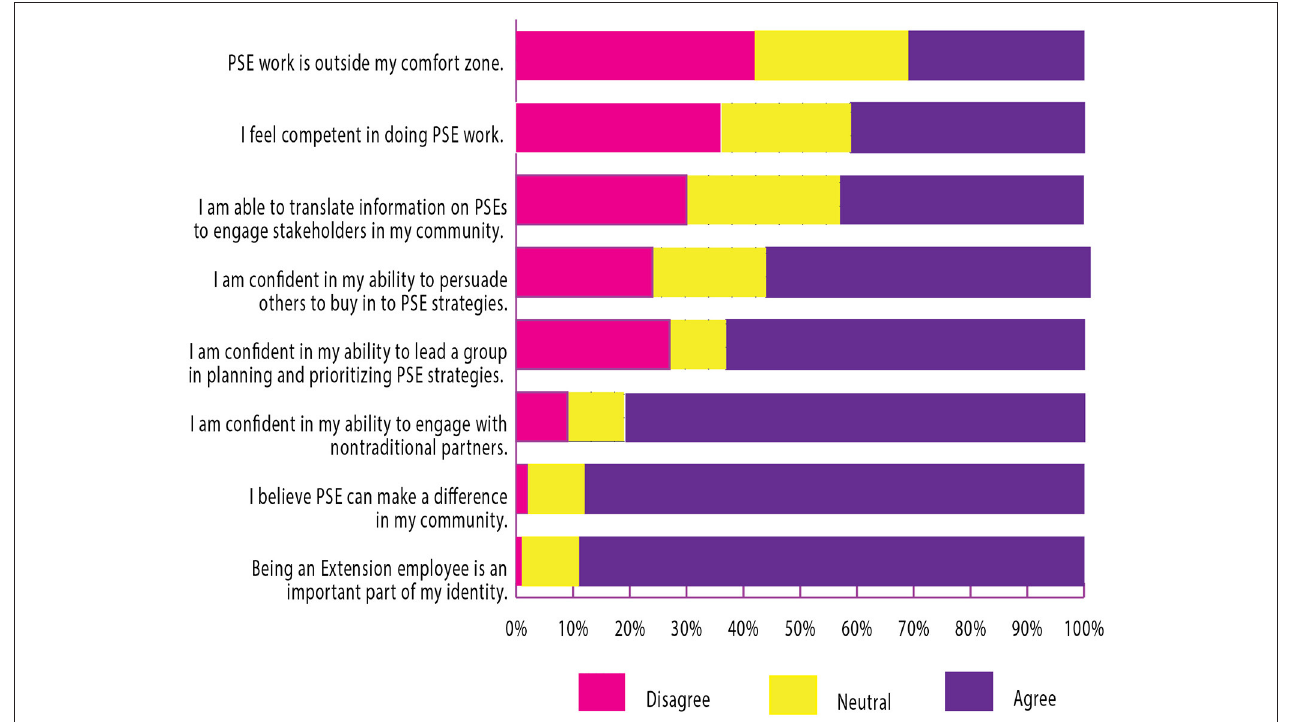
FIGURE 3 | Characteristics of